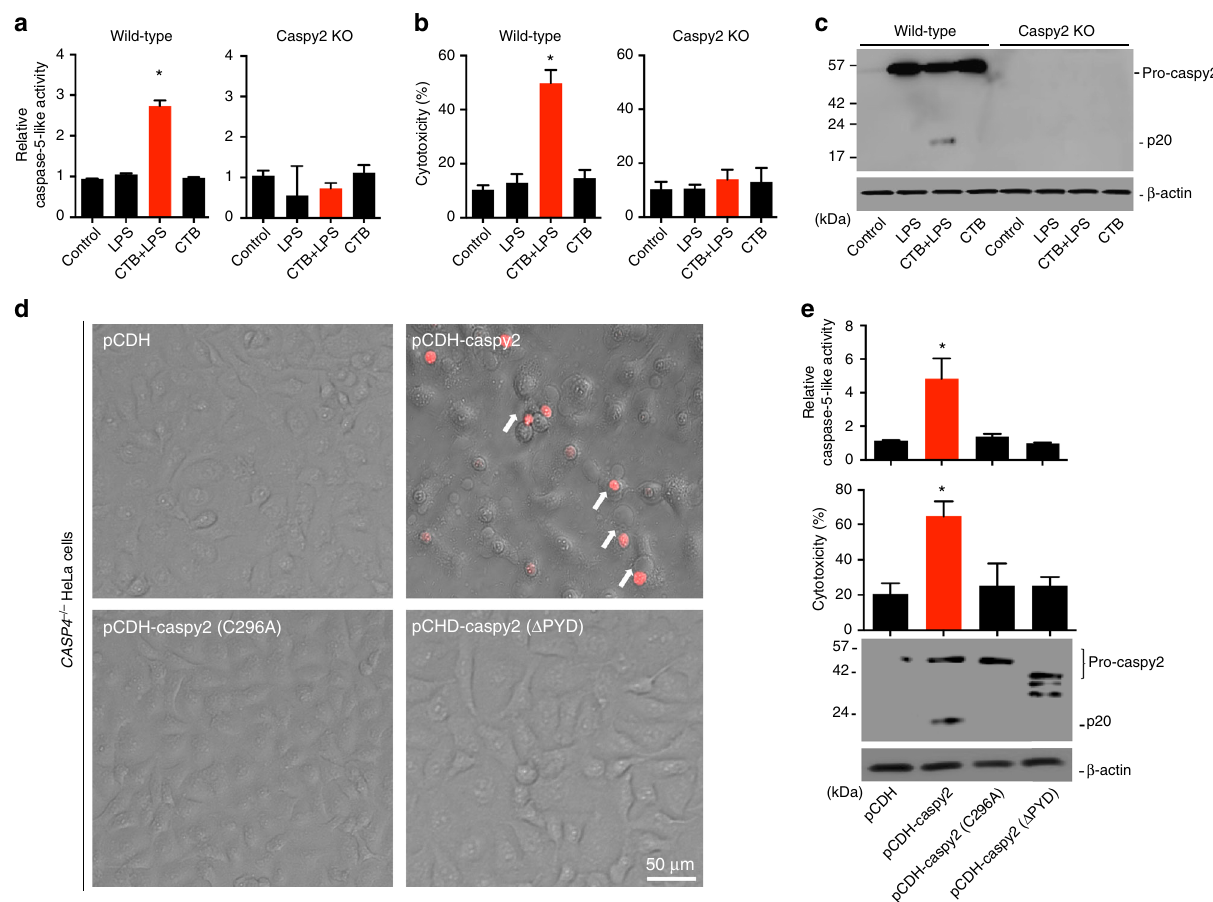
Fig. 4 Intracellular LPS-triggered-caspy2 noncanonical in fl ammasome activation. a - c ZF4 cells were primed with Pam3CSK4 for 4 h, before being stimulated with cholera toxin B subunit (CTB) plus LPS, LPS, or CTB alone for 12 h. Relative caspase-5-like activity was measured by incubating cell lysates with fl uorogenic and chromogenic caspase-5 substrates (WEHD) ( a ). Supernatants from the indicated HeLa cells were analyzed for cell death, as measured by lactate dehydrogenase (LDH) release ( b ). Mixtures of cell lysates and supernatants were subjected to immunoblotting ( c ). d , e CASP4 − / − HeLa cells were transduced with a vector expressing wild-type caspy2, caspy2 (C296A), caspy2 ( Δ PYD), or the empty vector. Cells were primed with LPS for 4 h, before being stimulated with CTB plus LPS for 12 h. Images were taken as in Fig. 1d ( d ). Propidium iodide (PI) was added to detect the loss of plasma membrane integrity. Arrows denote cells with pyroptotic-like features. Scale bar, 50 µ m. Relative caspase-5-like activity and LDH release assays were conducted as in a and b ( e ). Immunoblotting for the caspy2 forms indicated is shown. a – e Results are representative of at least three independent experiments, and error bars denote the SD of triplicate wells. * p < 0.05 ( t ZF4 cells were stimulated with 0909I or EIB202 E. piscicida , and digitonin-solublized cell lysates were resolved by blue native PAGE with 0.5% Triton X-100, followed by western blotting with anti-caspy2 antibodies. A large oligomeric complex containing caspy2 was induced in wild-type ZF4 cells upon infection with 0909I, but not with EIB202 E. piscicida (Fig. 3d). Taken together,